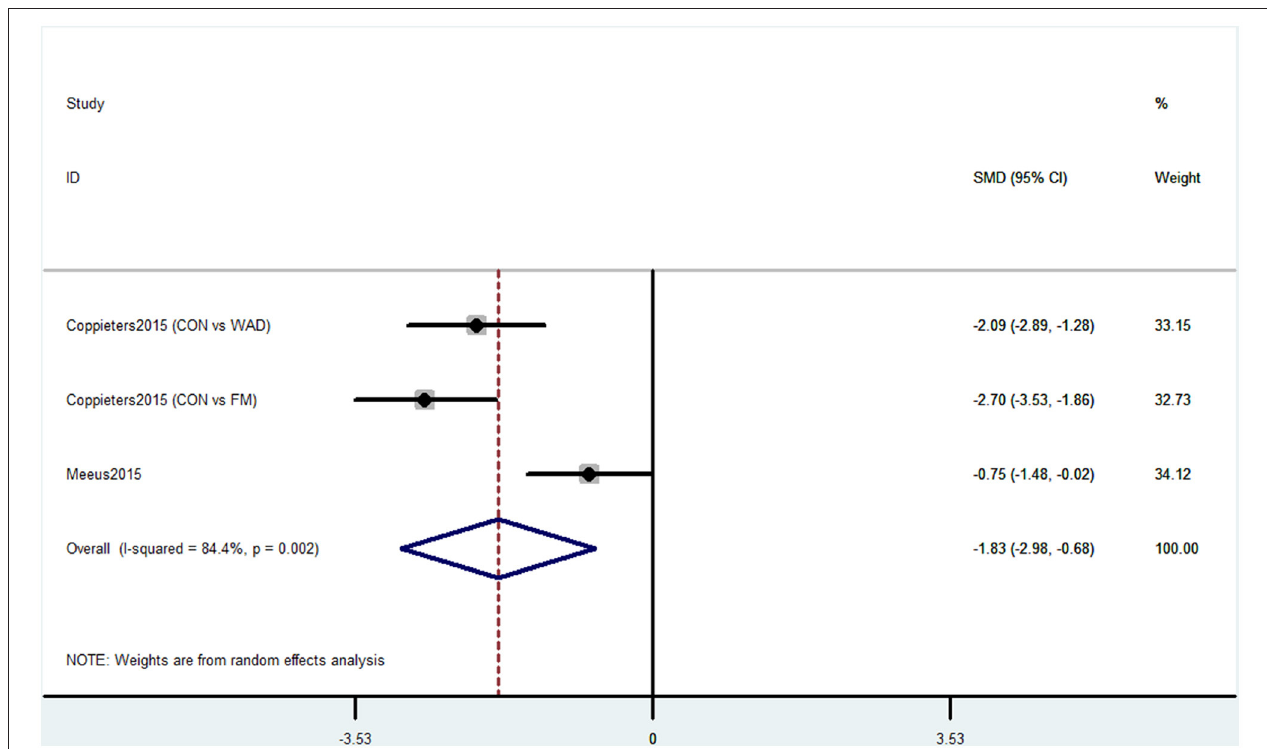
FIGURE 5 | Forest plot of the SMD and 95% CI from a random-effects meta-analysis for the association between chronic pain and incidence of cognitive decline when OSPAN was used. The rhombi represent the pooled SMD for this association. CON, control group; WAD, whiplash-associated disorder group; FM, fibromyalgia syndrome